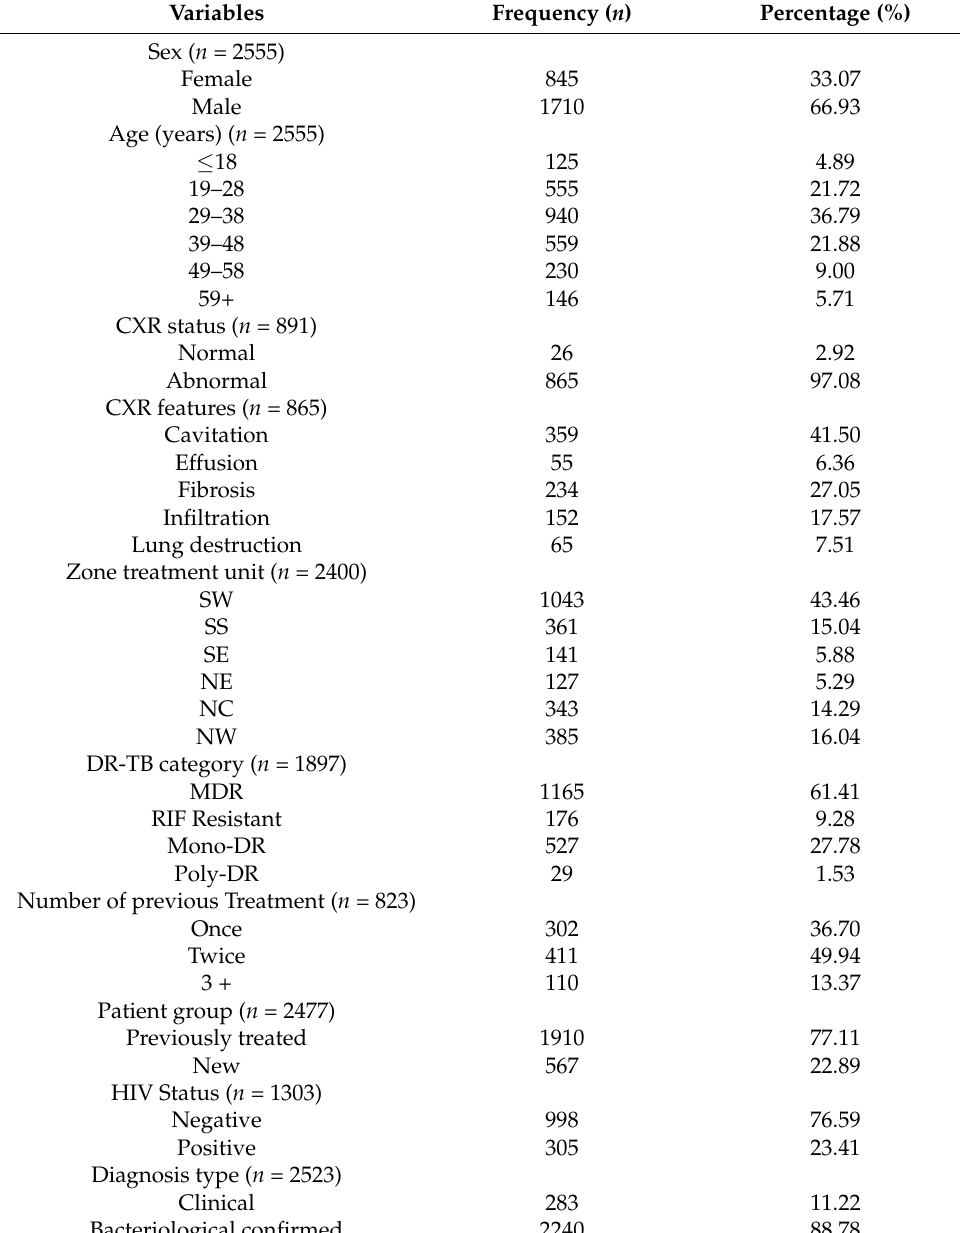
Table 1. Frequency table of Chest X-ray findings at presentation among drug-resistant tuberculosis cases in Nigeria ( n =